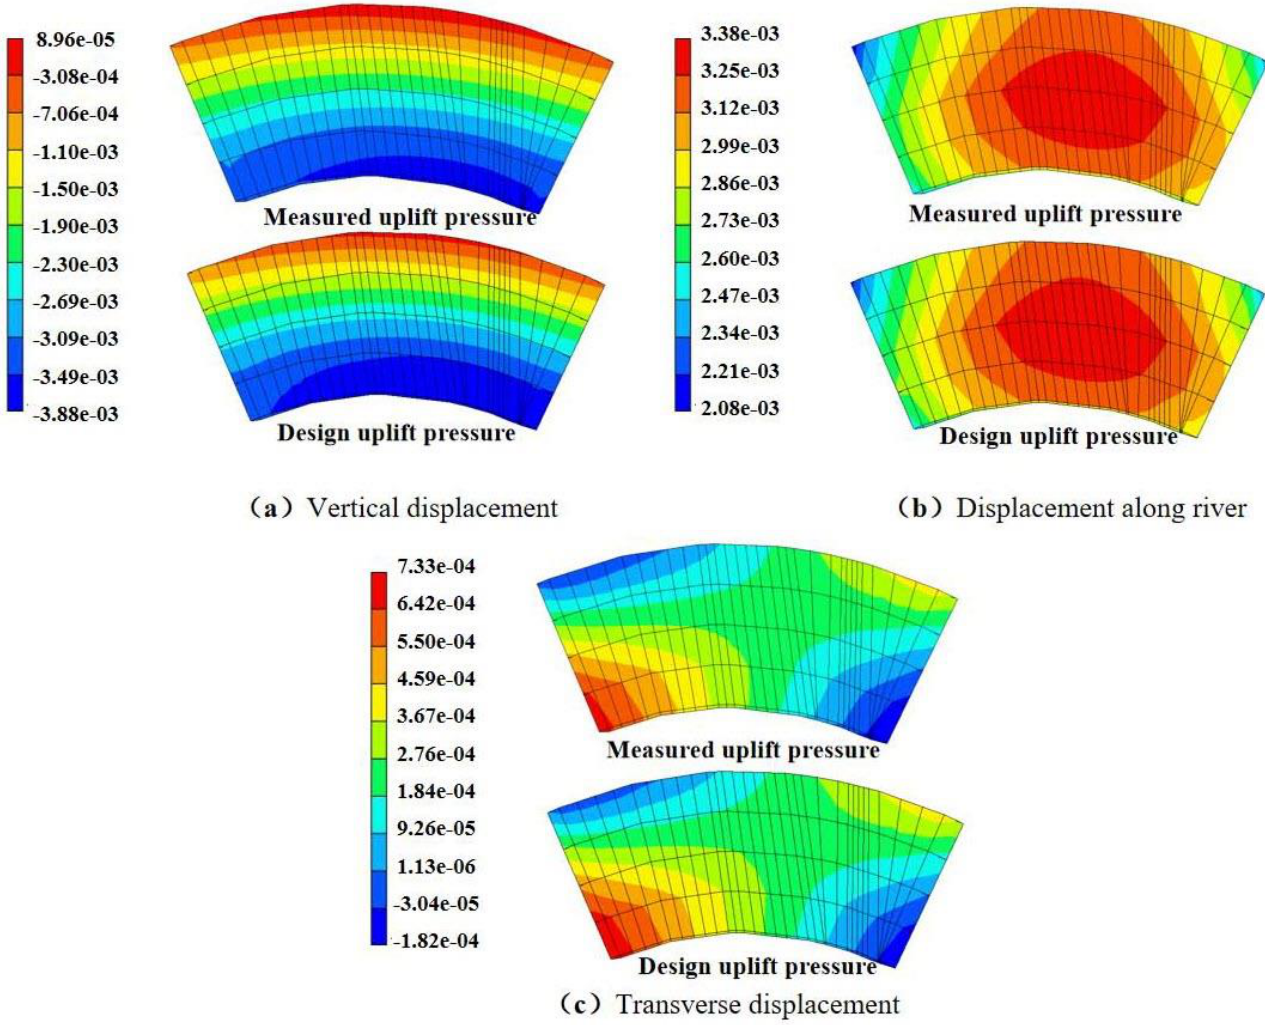
Figure 16. Contour map of foundation displacement under the measured uplift pressure (Unit: m).